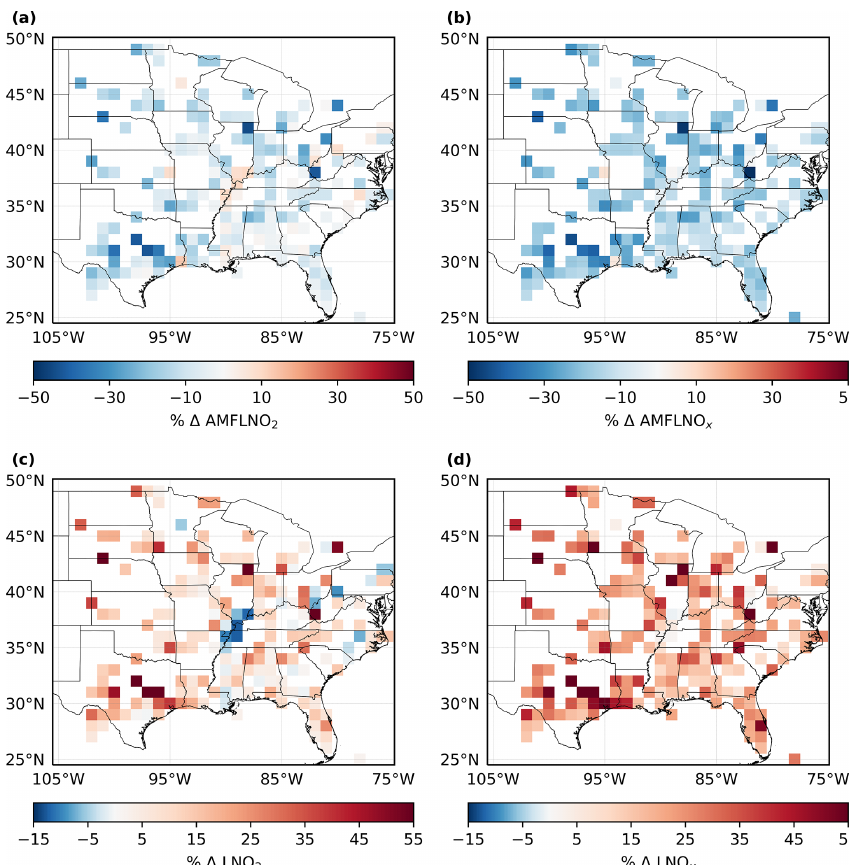
, (b) AMF LNO , (c) LNO 2 , and (d) LNO x with CRF ≥ 90% over MJJA 2014. x 2